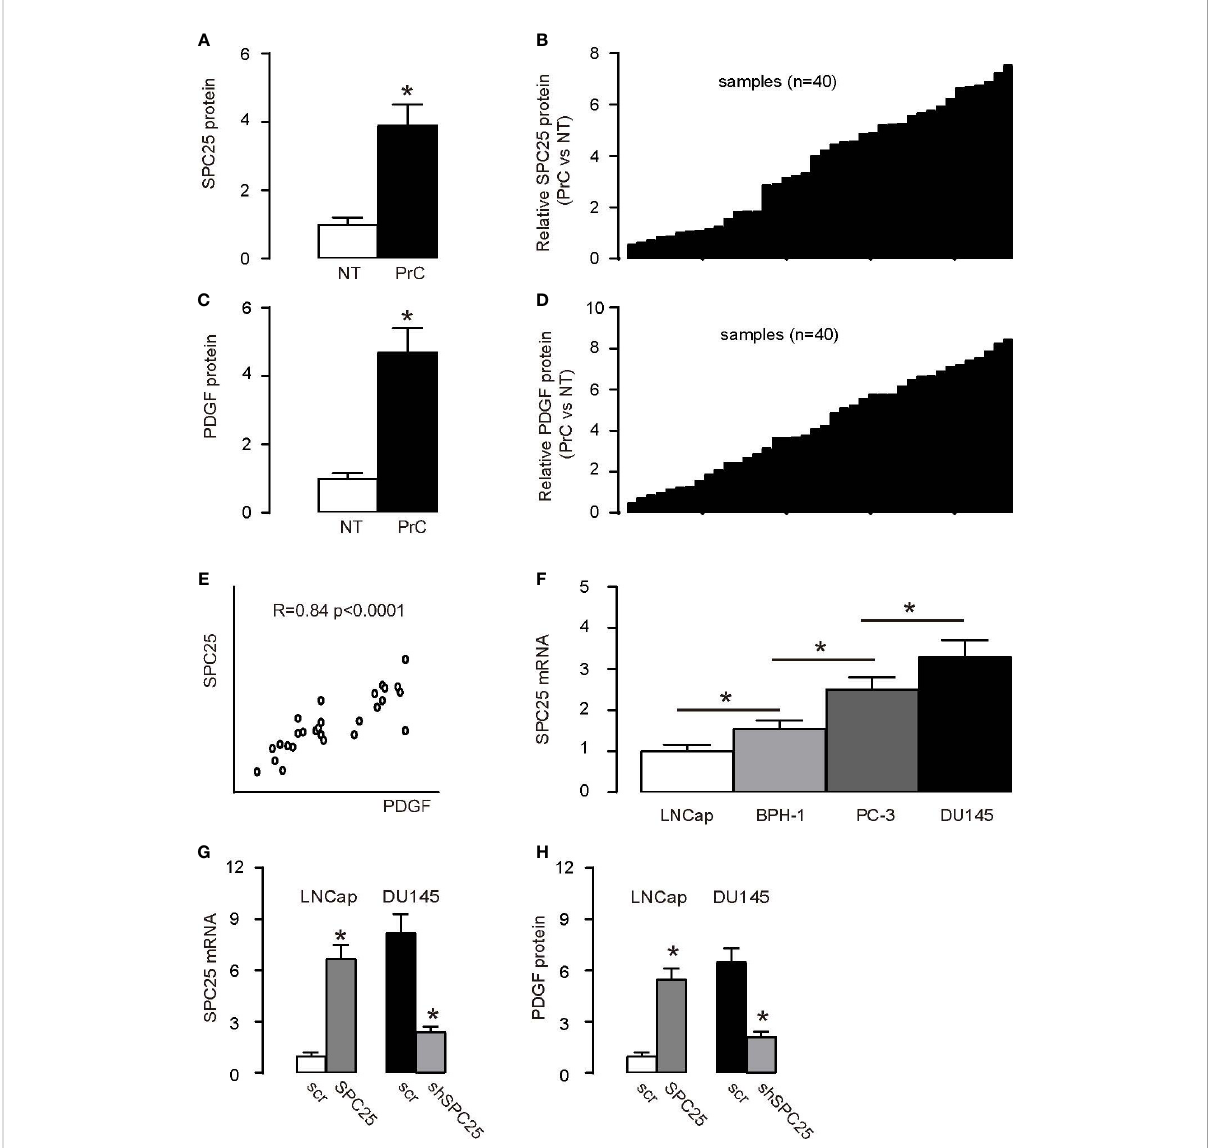
FIGURE 1 SPC25 increases PDGF levels in PrC (A, B) ELISA measurement of SPC25 protein level in 40 pairs of prostate cancer (PrC) and normal tissues (NT) as a group (A) , and as per pair (B) . (C, D) PDGF protein levels measured by ELISA in 40 pairs of PrC and NT, as a group (A) , and as per pair (B) . (E) Correlation between SPC25 and PDGF in PrC specimens ( R = 0.84; p < 0.0001). (F) RT-qPCR for SPC25 in several human PrC cell lines. (G) mRNA level of SPC25 in human PrC cell lines DU145 and LNCap transfected by either shSPC25 or SPC25, compared to cells transfected by scrambled plasmids (scr). (H) ELISA for SPC25 in DU145 and LNCap transfected by either shSPC25 or SPC25, compared to cells transfected by scrambled plasmids (scr). * p < 0.05. n = 40 for clinical studies (A – E) and n = 5 for cell line studies (F, G) . Relative values were shown. For (F, G) , Scr =